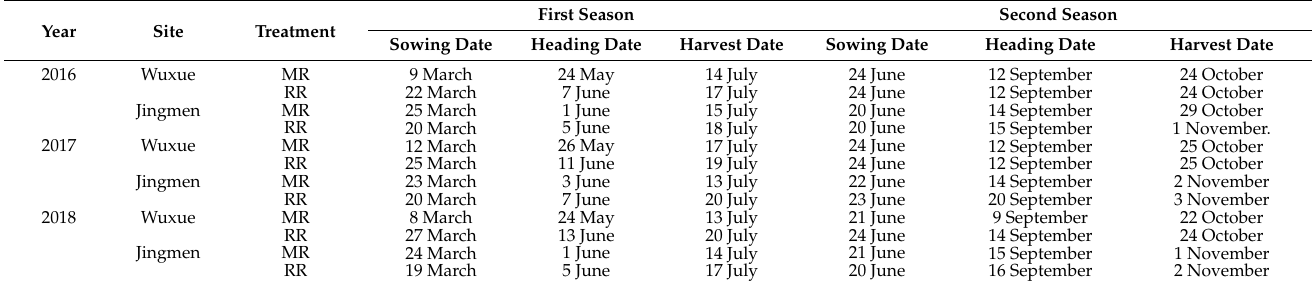
Table 1. Two cropping systems with different planting density, sowing, flowering, and harvest date under the first and second seasons at Wuxue and